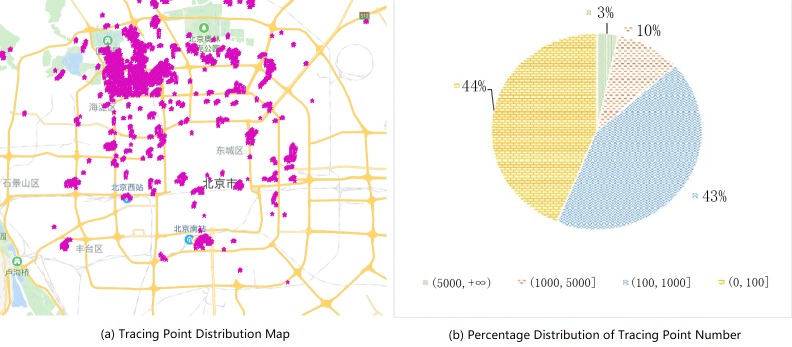
Tracing point distribution on GeoLife.